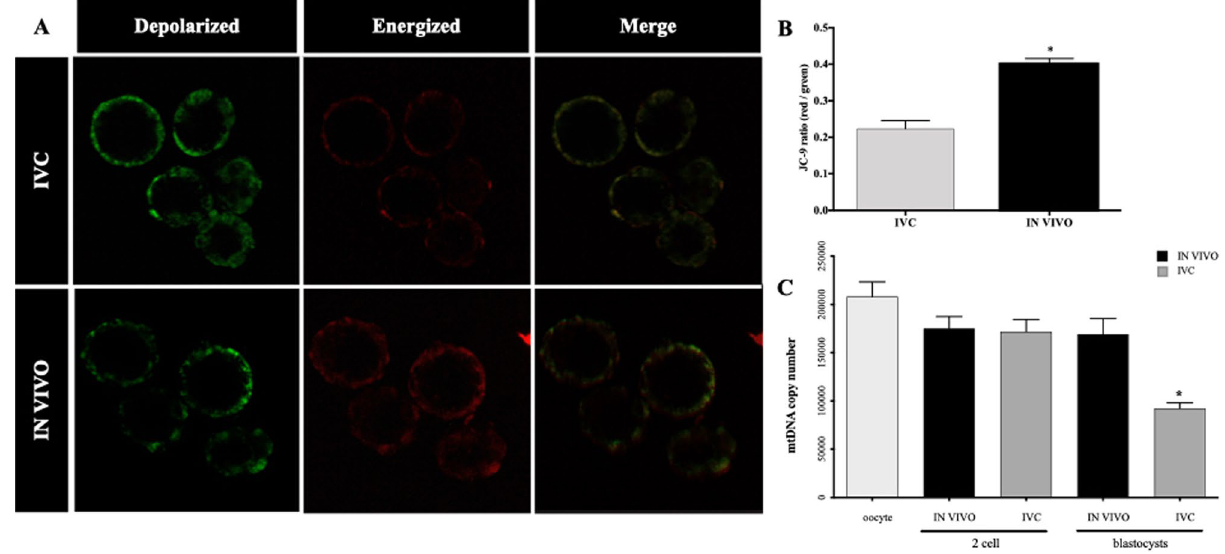
Figure 3. Assessment of mitochondrial depolarization using JC-9 die. ( A ) Representative images of mouse blastocysts stained with JC-9 dye of IVC (upper) and IN VIVO (bottom). Monomers of JC-9 were detected as green fluorescence while dye aggregates yielded red to orange colored emission. Scale bars: 10 µm. ( B ) Statistical analysis of the red and green mean fluorescence intensity ratios revealed that mitochondrial membrane potential in IVC embryos was significantly lower than that in the in vivo-developed blastocysts. ( C ) Assessment of mtDNA copy number in in vivo-developed and IVC embryos at the 2-cell- and blastocyst stage. The graph presents mtDNA copy number per embryo (n = 10/group); *significant difference at P <